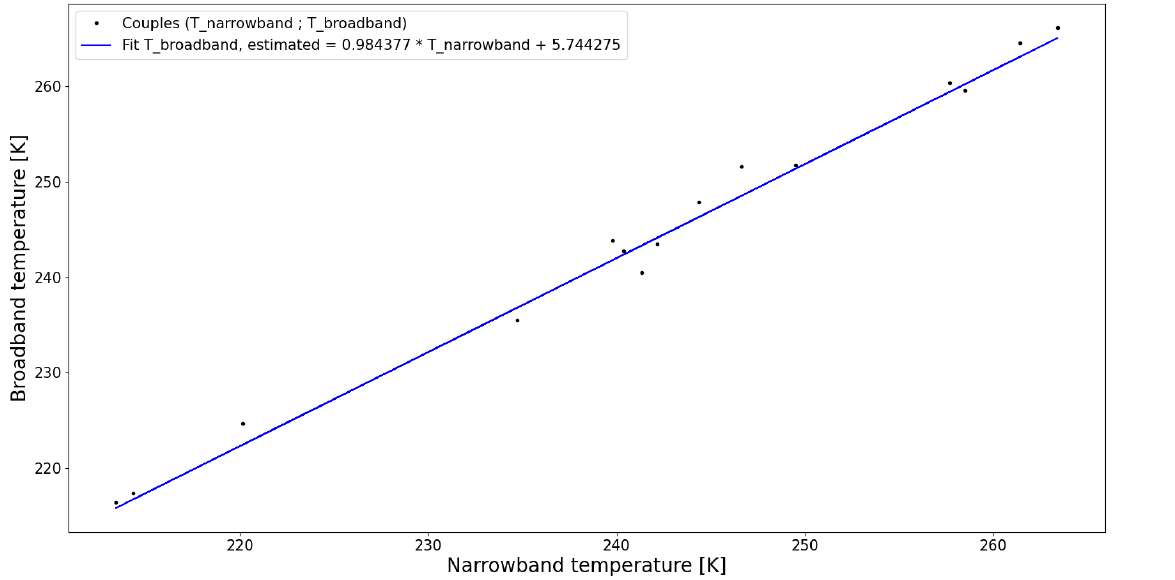
Figure 11. Couples of narrowband temperature and broadband temperature for simulated scenes, listed in Table 3. Line: linear fit of the broadband temperature as function of the narrowband temperature. RMSE = 1.498 and R 2 =